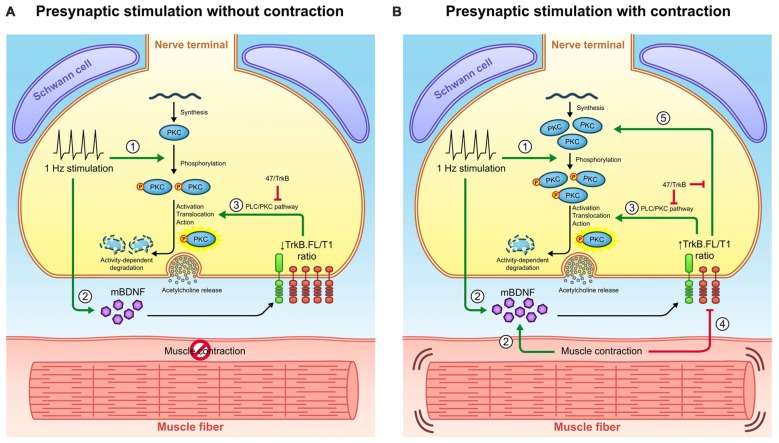
Retrograde communication from myocytes to axon terminals through BDNF/TrkB signaling. (A) Graphical representation of BDNF signaling outcomes observed under presynaptic stimulation without muscle contraction and presynaptic stimulation with muscle contraction. Presynaptic activity (1) promotes cPKC phosphorylation and (2) increases BDNF levels. BDNF acts presynaptically through (3) TrkB/PLCγ/PKC pathway to complete the activation of pPKC and thus enhance synaptic vesicle fusion and ACh release. Once PKC have executed their action, they are typically degraded thus decreasing its protein levels. (B) Graphical representation of BDNF signaling outcomes observed under presynaptic stimulation with contraction. The presence of contraction (2) further increases BDNF protein levels and (4) decreases TrkB.T1 protein levels, ultimately increasing the ratio TrkB.FL/T1. Even though this ratio still enhances (3) cPKC activity and its subsequent degradation, it promotes the increase in total PKC protein levels (5). Presumably, this might be due to an increase in PKC synthesis or alternatively, to a decrease in their activity-induced degradation. Consequently, pPKC levels are enhanced. The influence of TrkB.FL/T1 ratio over cPKC in both conditions is demonstrated by the sequestering antibody 47/TrkB. Therefore, muscle contraction could modulate BDNF/TrkB signaling to promote a retrograde regulatory feedback from the myocyte that maintains the levels of presynaptic cPKC. This may have an impact in NMJ functionality since cPKCβI activity is required for acetycholine release.